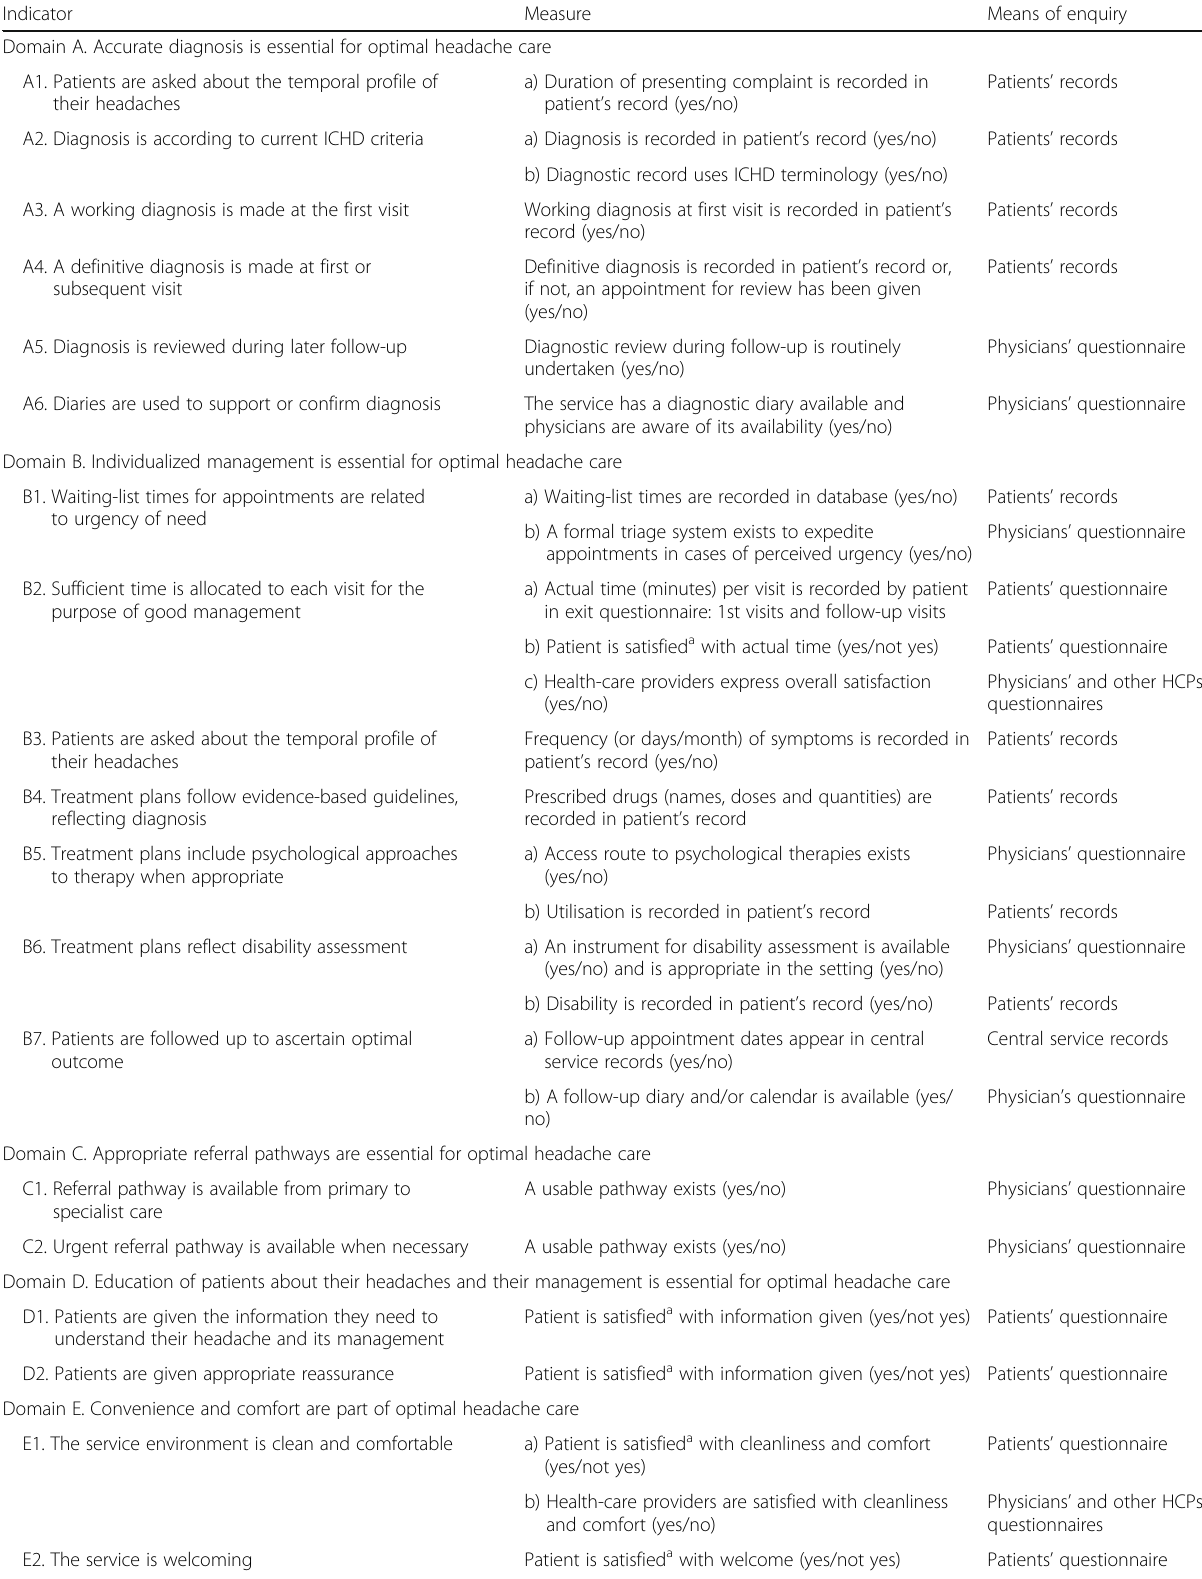
Table 2 Methods of implementation of service quality